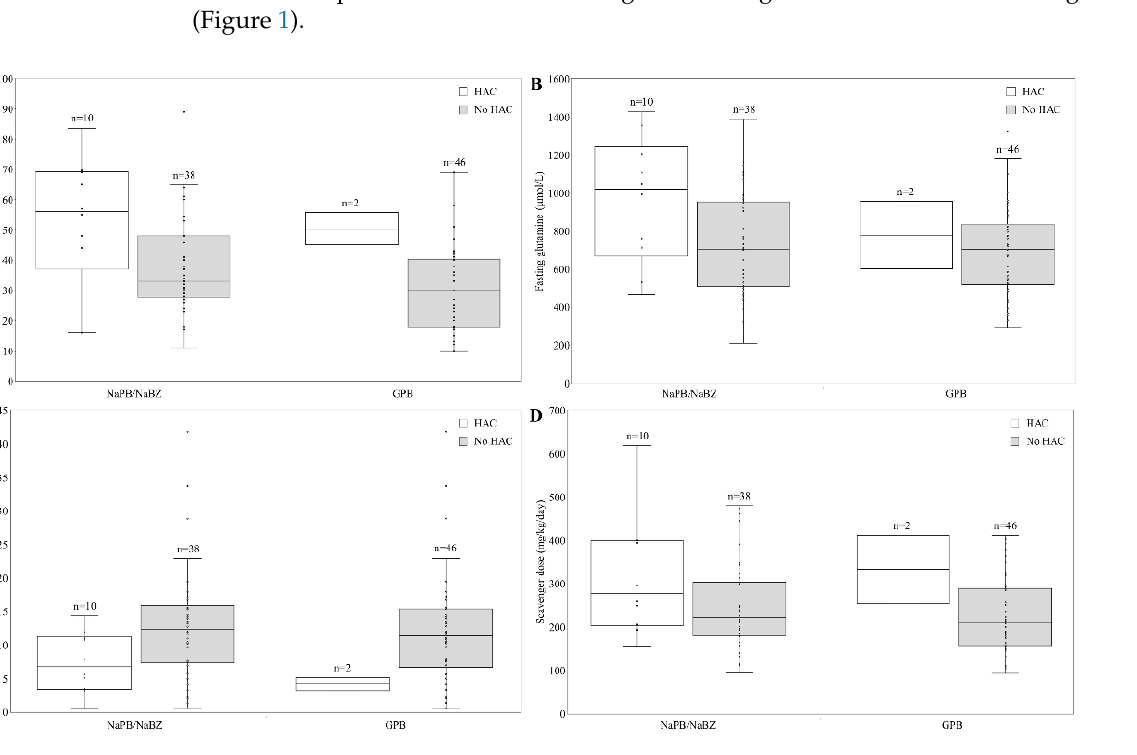
Table 4. Ammonia, glutamine and hyperammonemic crisis.